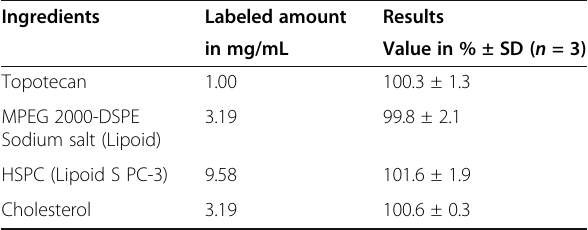
Table 1 Quantification results of drug and lipids in topotecan liposomes